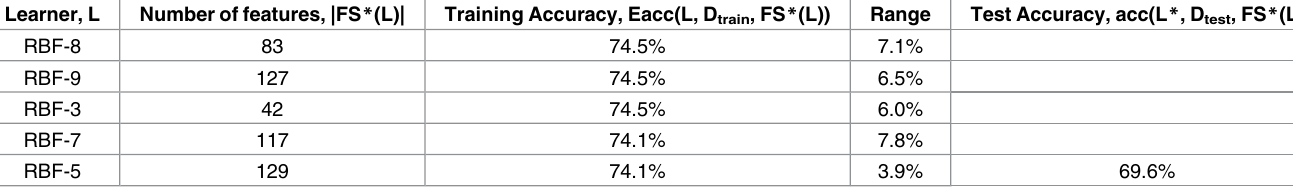
of functional images and personal characteristic data. These analyses were chosen as they Table 12. ADHD-200,personal characteristic data with structural images. Learner,